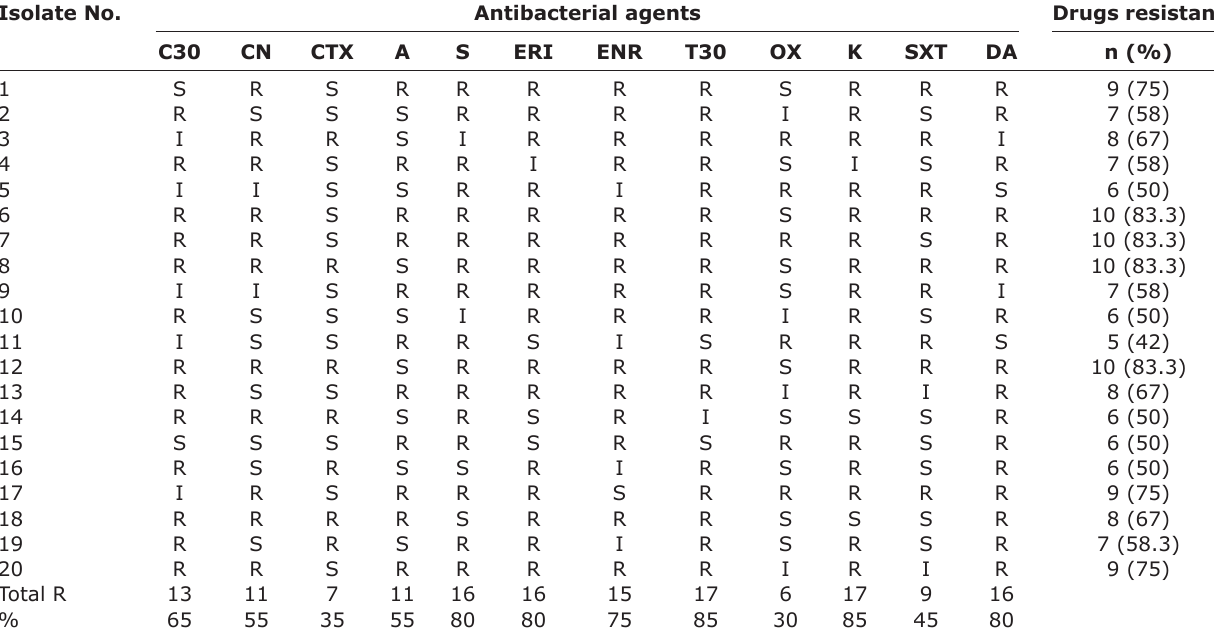
Table-3: Antimicrobial sensitivity pattern of tested E. coli isolates (n=20). Isolate No.